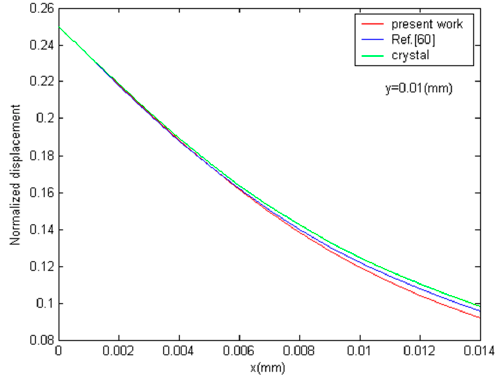
 (cid:107) with x ( y = 0.01mm). Crystals 2016 , 6 , 152 3